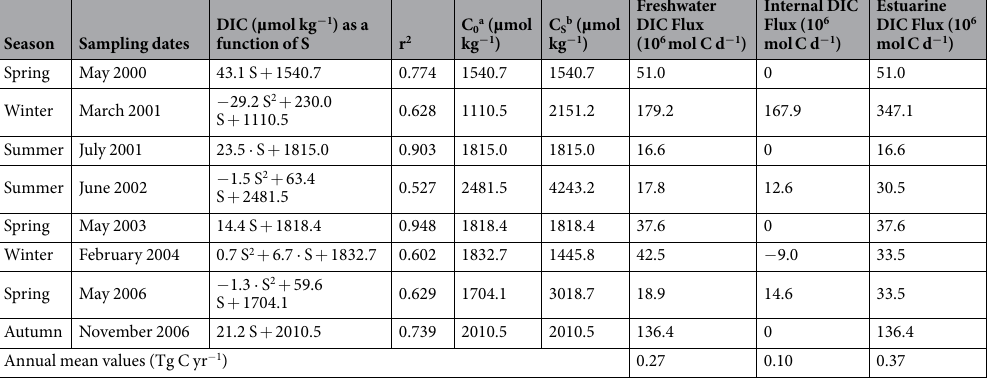
Table 3. Dissolved Inorganic Carbon (DIC) distributions and fluxes in Tagus estuary. Equations are polynomial equations used to fit the data from DIC versus salinity for each sampling transects. All equations have p < 0.05. C 0 and C S are, respectively, freshwater and seawater DIC concentrations. The flux of freshwater DIC is defined as (Q · C 0 ), whereas the flux of internal DIC is (Q · (C S − C 0 )) and the estuarine flux is (Q · C S ). Q represents the Tagus River flow. a DIC concentration where the polynomial equation intersects the y-intercept (or the concentration at zero salinity) b DIC concentration where the tangent at the marine end-member crosses